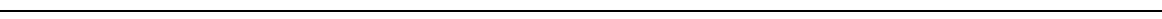
Fig. 5 Absence of inhibitory terminals following distal axotomy and frequency of their spontaneous release events. a Representative images of fi xable FM4- 64FX puncta ( red ) and vGLUT1 ( green ) co-immunolabeling in uninjured chambers and 48 h following axotomy. White circles highlight vGLUT1 expression at FM-labeled terminals. Scale bars , 10 µ m. Fraction of vGLUT1 + FM puncta per neuron fi eld at 48 h post-axotomy normalized to uninjured controls. n = 18 neuron fi elds; 5 chambers over 3 experiments. b Fixable FM4-64FX puncta ( red ) and GAD67 ( green ) co-immunolabeling. Quanti fi cation of GAD67-positive FM puncta at 48 h post-axotomy normalized to control. n = 21 neuron fi elds; 5 chambers over 3 experiments. c Number of vGLUT1 and vGAT puncta per neuron area (axotomized or control) 48 h post-axotomy. n = 8 – 9 neurons; 3 chambers per condition over 3 experiments. a – c Unpaired two-tailed t-test. d Representative traces of mIPSC recordings 48 h post-axotomy. e Quanti fi cation of mIPSC frequency and amplitude 48 h post-axotomy (control, n = 9 neurons; axotomy, n = 17 neurons). (mIPSC frequency: unpaired two-tailed t -test with Welch ’ s correction, p = 0.05; mIPSC amplitude: unpaired two-tailed t -test, p = 0.62). f Analysis of mIPSC frequency and amplitude from axotomized devices previously shown in e comparing neurons with axons that extended into the axonal compartment and were cut (cut, n = 8 neurons), to neurons that did not extend axons into the compartment and were not cut (uncut, n = 9 neurons). (mIPSC frequency: unpaired two-tailed t -test, p = 0.94; mIPSC amplitude: unpaired two-tailed t -test, p = 0.51). d – f Data shown were combined from 3 chambers. g Representative dendritic segments (retrogradely labeled with eGFP rabies virus) showing spines that are labeled with vGLUT1 ( red ) or vGAT ( magenta ) antibodies. White open circles highlight dendritic spines with vGLUT1 and/or vGAT synapses. h Fraction of vGLUT1- and vGAT-positive spines at 24 h post-axotomy. n = 12 – 14 neuron fi elds; 7 neurons per condition; #spines: 458 (uninj. cntl), 394 (axot.); 3 chambers over 3 experiments. i Fraction of vGLUT1- and vGAT- positive spines at 48 h post-axotomy. n = 11 – 15 neuron fi elds; 8 – 9 neurons per condition; #spines: 460 (uninj. cntl), 413 (axot.); 3 chambers over 3 experiments. Scale bars , 5 µ m. Unpaired two-tailed t -test. ** p < 0.01, *** p < 0.001. Error bars ,